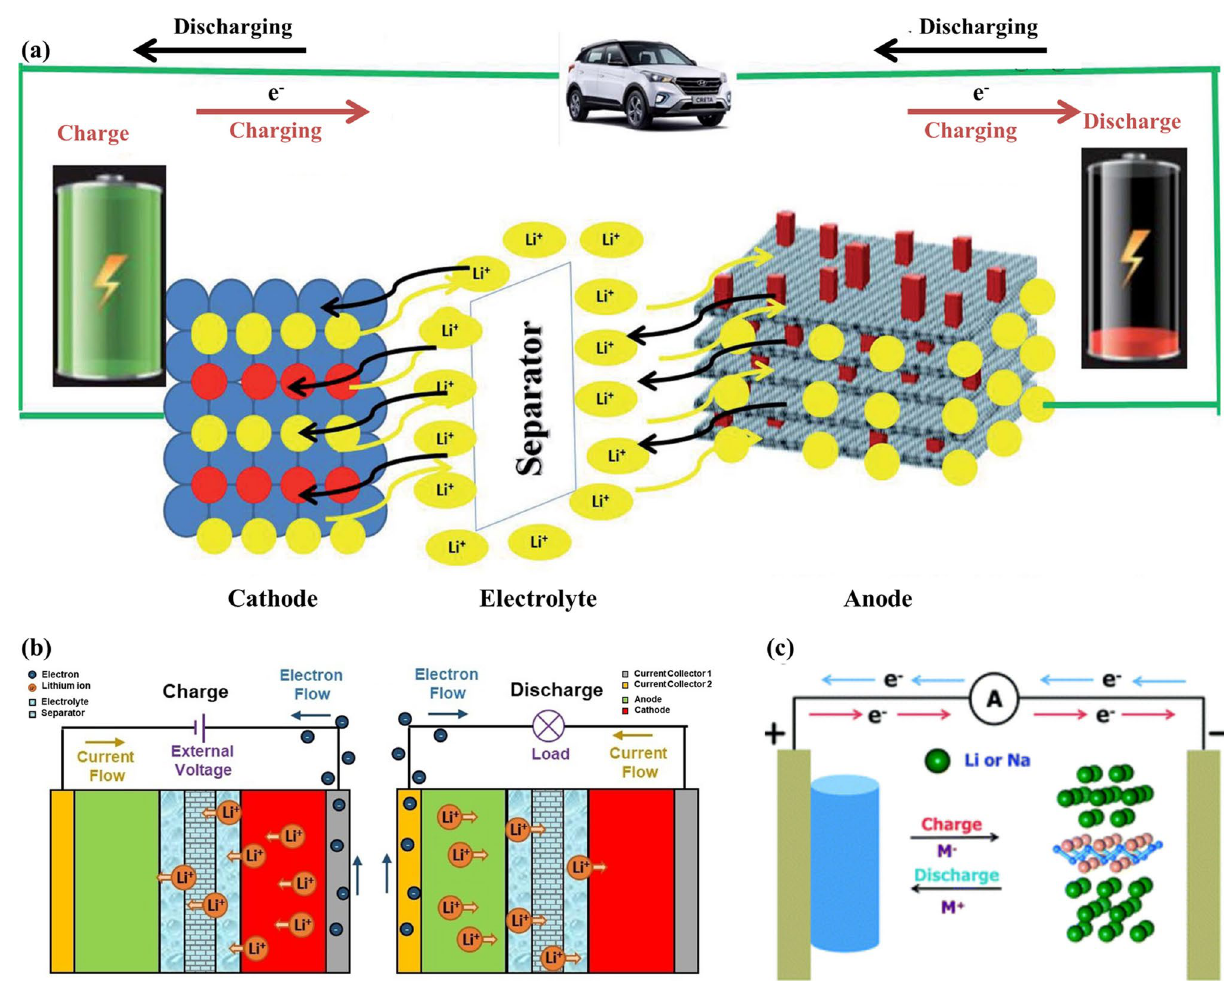
Fig. 18 a Schematic illustration of MXene-based anode batteries. Reproduced with permission from Ref. [47]. b Schematic structure of the metal-ion batteries showing the working mechanisms of the charge and discharge process. Reproduced with permission from Ref. [236]. c Sche- matic illustration of MBene-based anode batteries. Reproduced with permission from Ref.